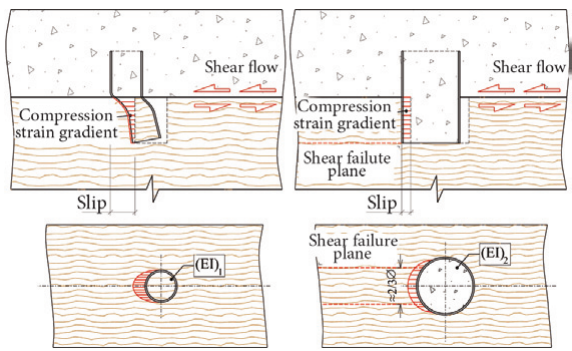
Fig. 14. Failure mechanism in case of ( EI ) 1 < ( EI )